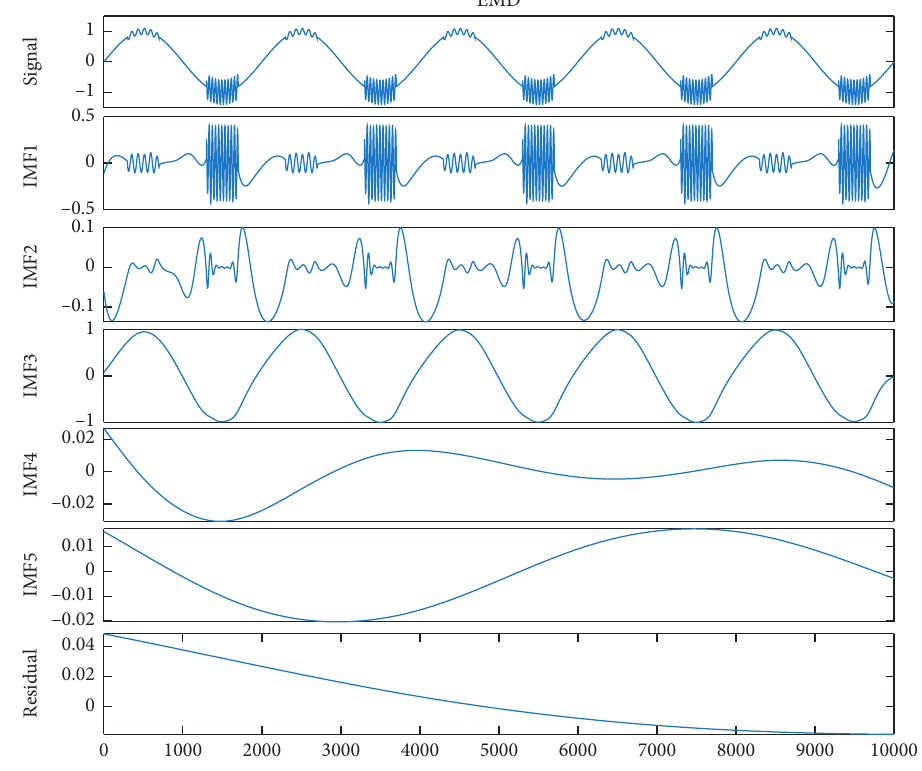
Figure 5: IMFs of EMD on simulation signal.